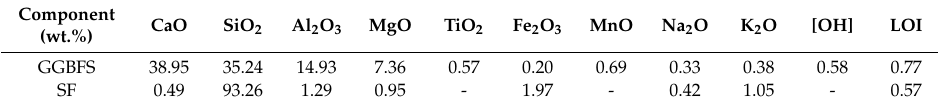
Table 2. Chemical compositions of GGBFS and SF.